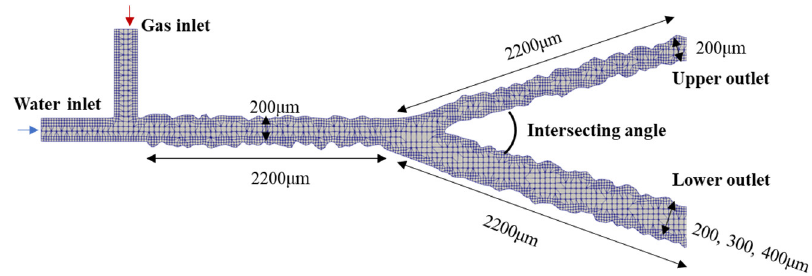
Figure 4. Illustration of the geometry of the Y-shaped fracture model.